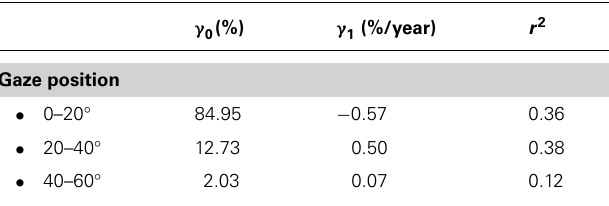
Table 3 |Values of the linear regression analysis for the gaze